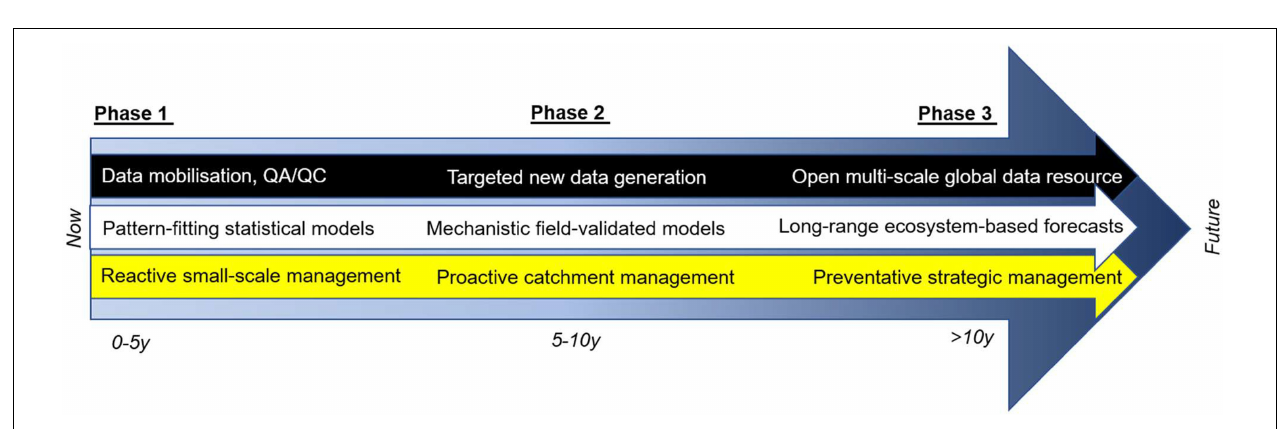
FIGURE 2 | Map of rivers throughout the European range of Atlantic salmon with long-term population dynamics data (white stars), some of which contain additional high resolution food web data (yellow stars—Vesturdalsá in Iceland and River Frome in the United Kingdom—note this list is not exhaustive). Long-term time series of salmon population dynamics are shown for these two rivers, along with a third site in Spain (River Pas), which contains food web data that is not yet standardized across trophic compartments. The quantified food webs for the Vesturdalsá and River Frome highlight the consistent scaling of biomass flux through the food web, with trophic biomass pyramids shown in the insets (colors correspond to the major trophic groups: diatoms in green, invertebrates in blue, salmonids in red, and other fish in purple). Note that the width of the bars in the trophic pyramids equates to total biomass on a log scale. The final column illustrates the use of biomass pyramids to identify potential for a management intervention, with recent construction of a salmon ladder on the Mi ð fjar ð ará in Iceland aimed at converting the excess biomass of invertebrates above the waterfall into salmon biomass.